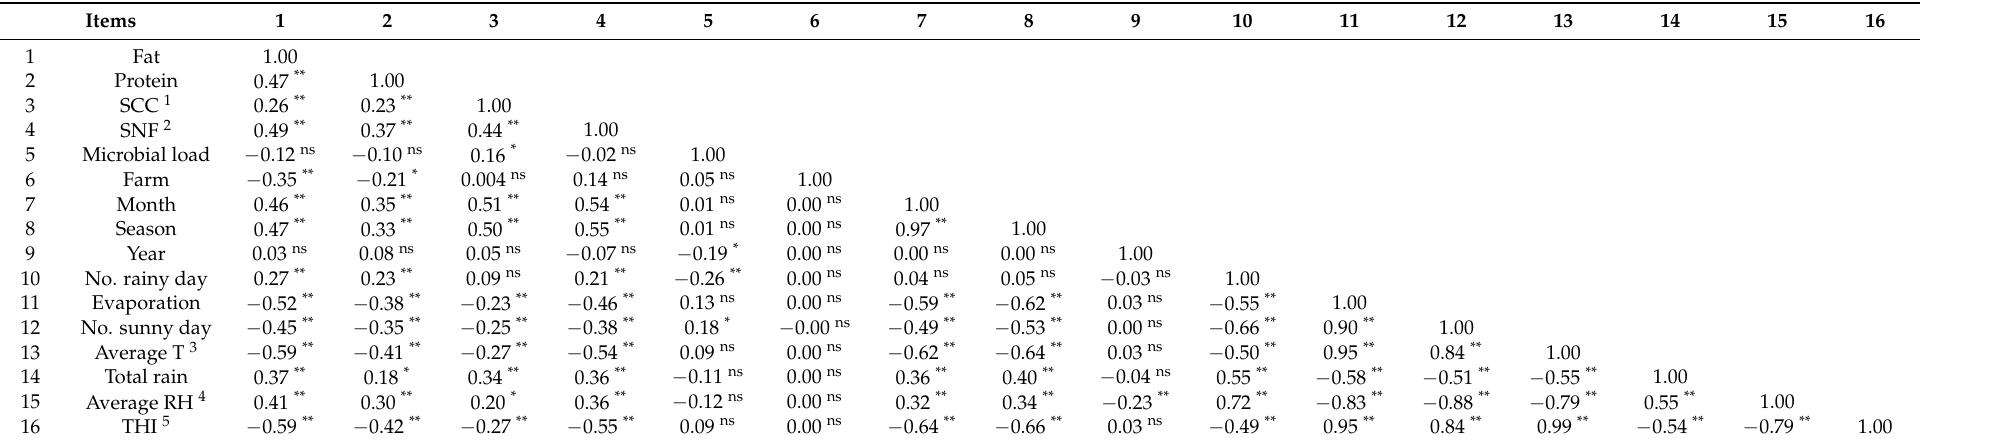
Table 2. Analysis of correlation coefficients between measured parameters of milk composition and environmental